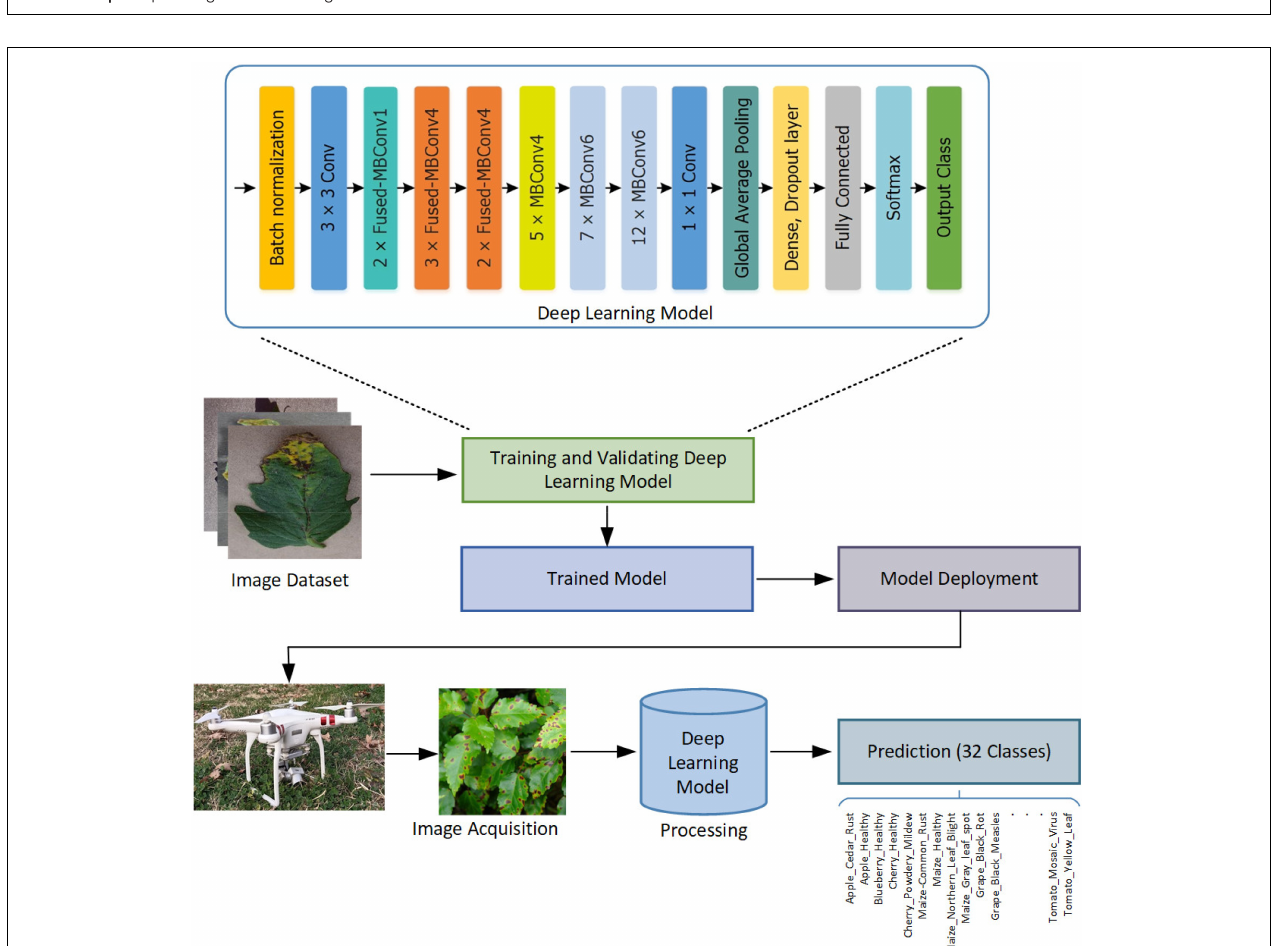
FIGURE 3 | Architecture of the proposed model based on improved EfficientNetV2-B4.